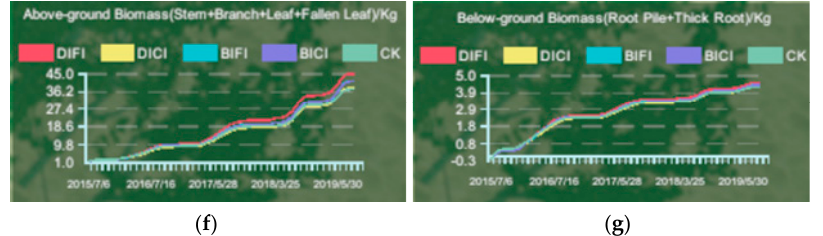
Figure 12. DBH-related trend plots of predicted stand status results. The five color icons represent